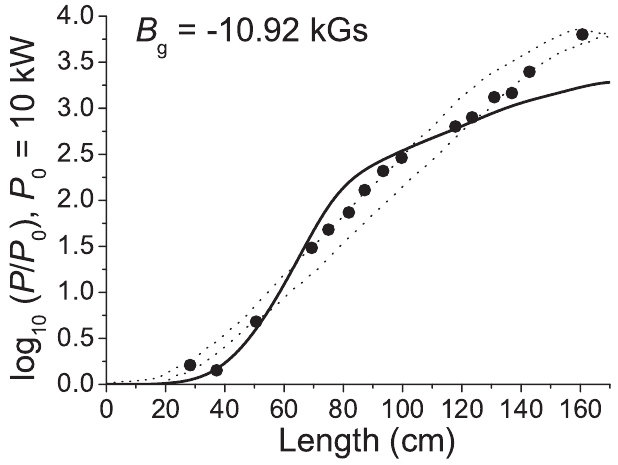
FIG. 1. Power of the FEM amplifier [11,12] versus length: experimental data (dots), simulation results from 3D code ARACHNE [16] (dotted lines for two sets of parameters within uncertainties imposed by the experiment: the lower curve for the (cid:2) 330 A , parameters listed in Table I; the upper one—for I b (cid:2) 1 : 55 kGs , P (cid:2) 10 kW ), and simulation results from B w in 1.5D code at the parameters of the experiment (solid